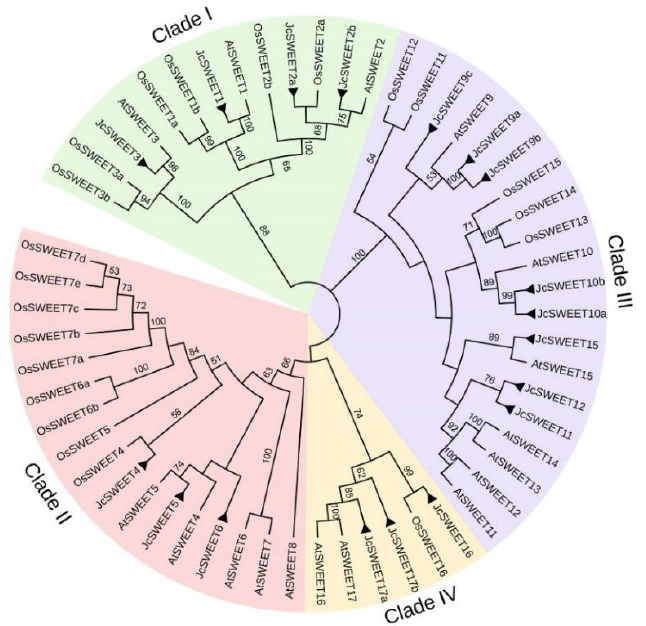
Figure 1. Phylogenetic relationships of SWEET family genes in physic nut, rice, and A. thaliana . The sequences of the SWEET proteins from the above three plant species were aligned by CLUSTAL_X, and the phylogenetic tree was constructed using MEGA 5.0 and the neighbor-joining (NJ) method with default settings. Jc, Jatropha curcas ; At, A. thaliana ; Os, Oryza sativa . JcSWEET genes are identified by black triangles.